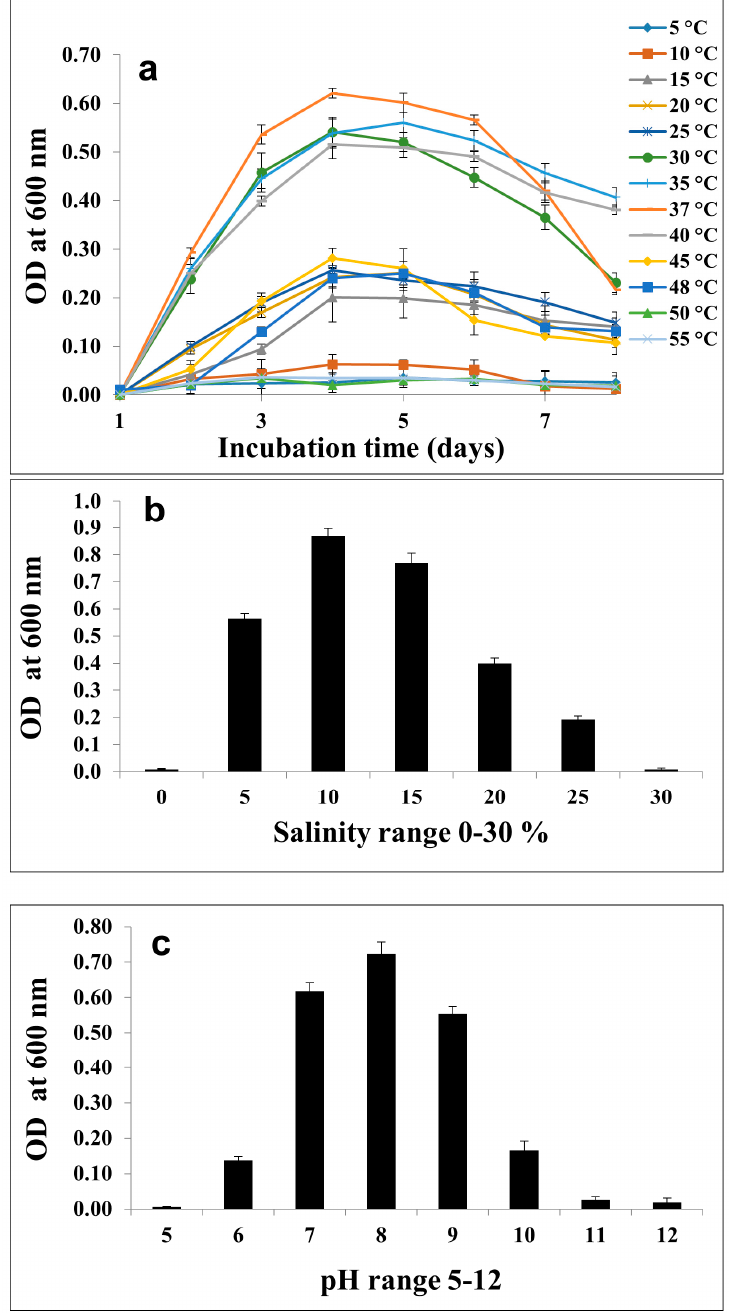
Figure 2. Growth pattern of the strain C12A1. ( a ) Temperature 5–55 °C. ( b ) 0–30% NaCl concentration in C modified medium. ( c ) pH ranges 5–12.